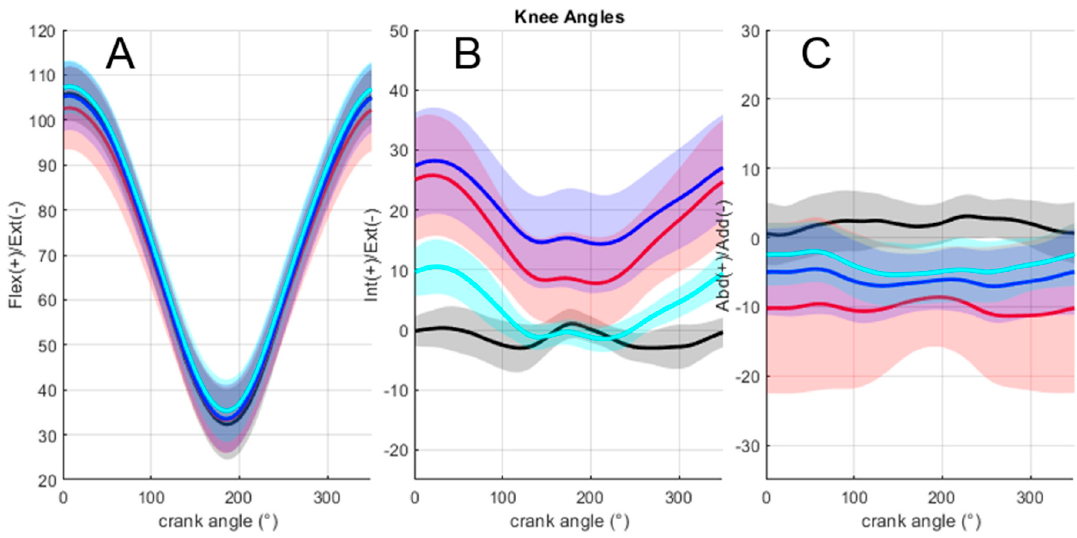
Figure 5. Mean and standard deviation of 3D knee joint angles across the population for all methods. ( A : flexion / extension; B : internal / external rotation; C : abduction / adduction). Red: static method; blue: mixed method; cyan: cycling method; black: anatomical method. Table 4. Knee joint root mean squared (RMS) errors using each calibration method in comparison to the values obtained from the reference optoelectronic system and the ISB convention RMS Error in the Knee Angle for Each p -Values Method (deg) S vs. M vs. DOF Static Mixed Cycling S vs. C M C Flexion/Extension 4.79 ± 3.03 3.65 ± 2.23 3.74 ± 2.99 0.38 0.82 Abduction/Adduction 11.18 ± 6.62 7.51 ± 4.13 15.37 ± 5.38 18.80 ± 8.05 < 0.001 Rotation